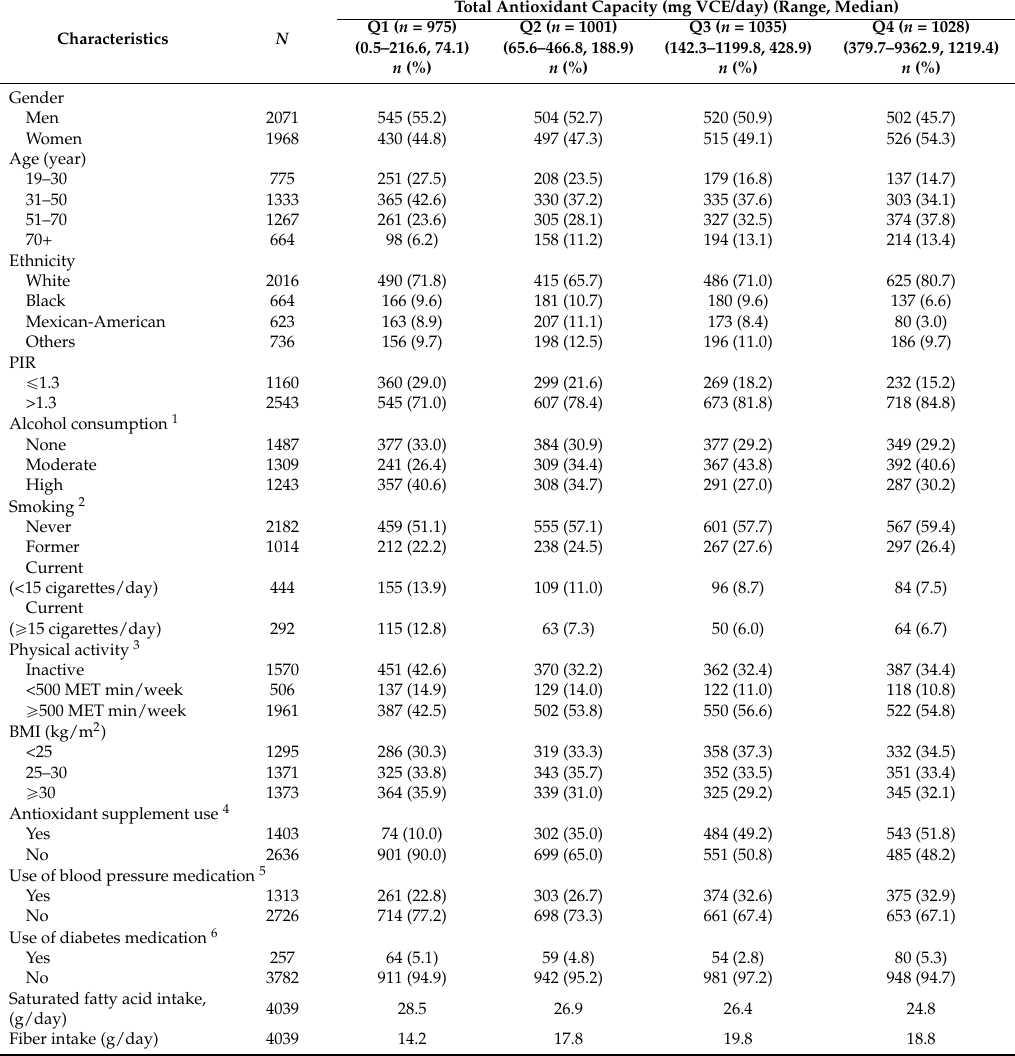
Sociodemographic and lifestyle characteristics by energy-adjusted quartiles of total antioxidant capacity among U.S. adults in the NHANES 2007–2012 ( n = 4039).